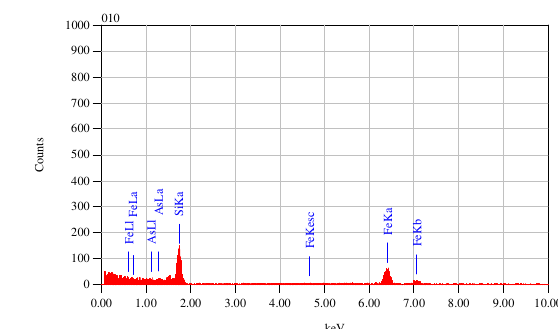
Fig. 15(b): Elemental analysis results of Shikarap Iron Ore after Adsorption.